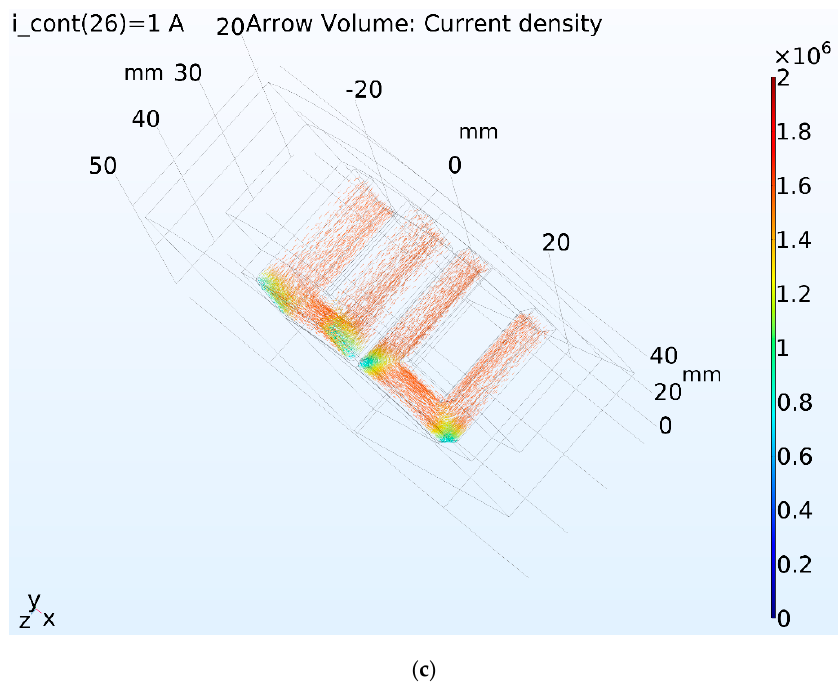
Figure 7. Current density for the control current − 1 A ( a ), 0 A ( b ), and 1 A ( c ).